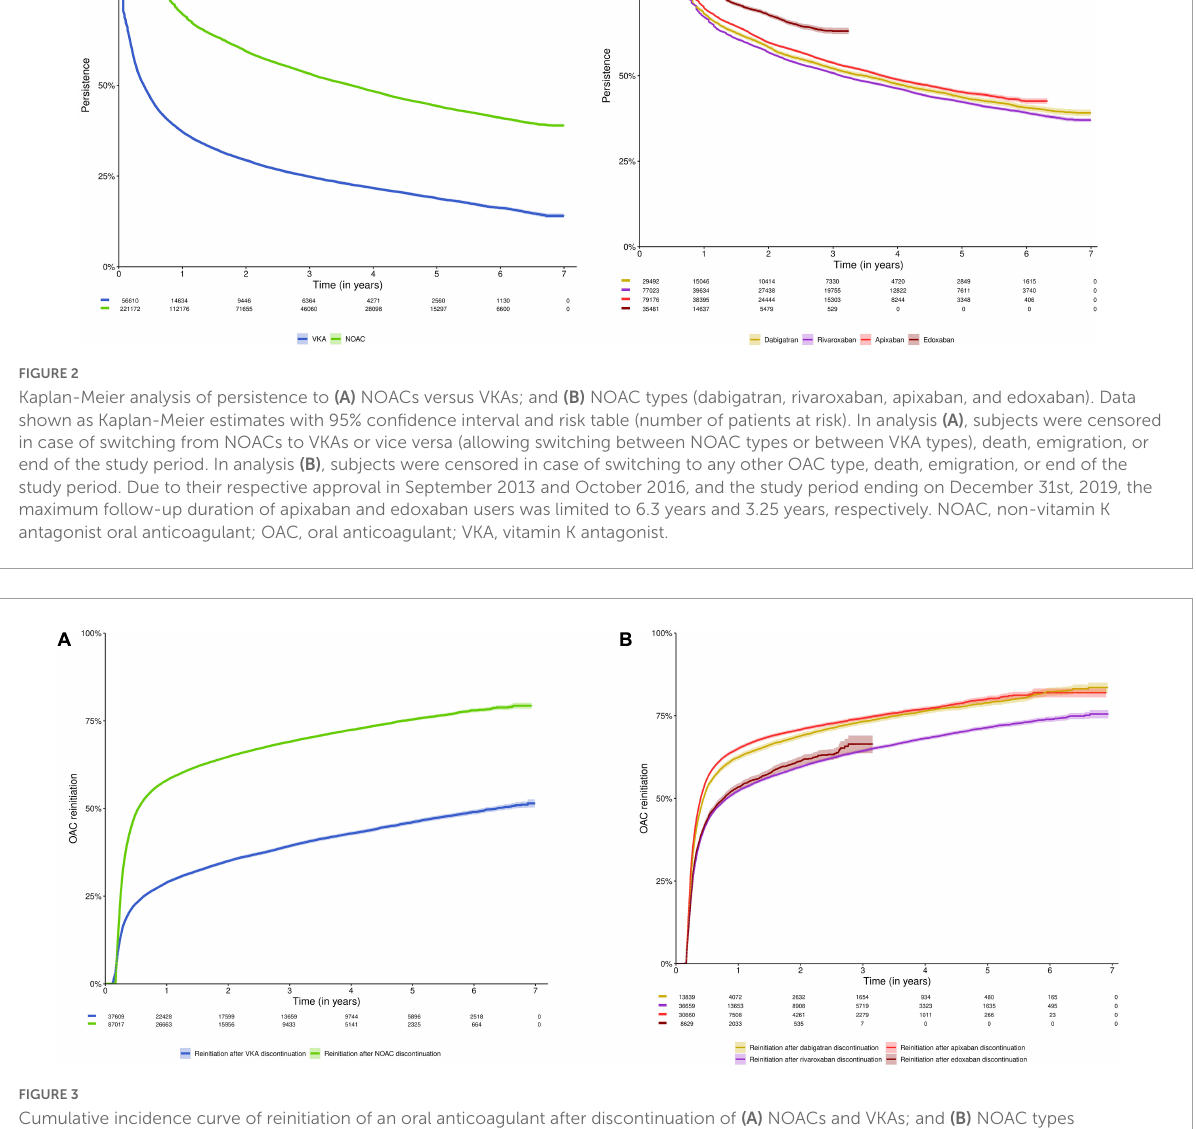
and 24.8% after 2 years, and 5.1% and 44.2% after 5 years, respectively ( p -value < 0.001) ( Figure 4A , Supplementary Table 3 ). The proportions of subjects switching dabigatran, rivaroxaban, apixaban or edoxaban to any other OAC were 11.8%, 7.2%, 4.6%, and 5.6% after 1 year; 15.8%, 10.3%, 6.1%,